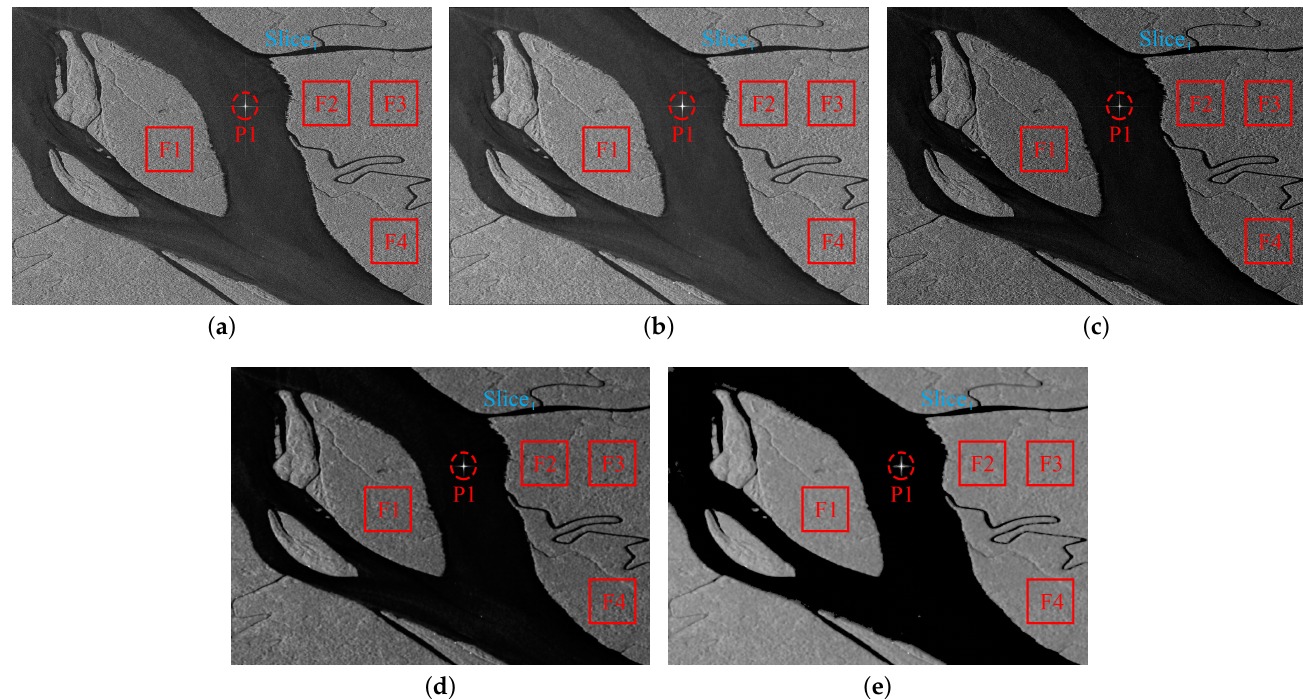
Figure 6. Experimental results for data 2 under full sampling condition. ( a ) Chirp scaling. ( b ) CSA + multilook processing using a 9 by 9 window. ( c ) L 1 regularization. ( d ) L 1 and TV regularization. ( e ) Nonconvex and TV regularization. The vertical direction of the image is the azimuth direction, and the horizontal direction is the range direction. SAR data 2 occupies 3115 (azimuth) × 4387 (range) sampling points, and the size of the corresponding scene is 19,228 m (azimuth) × 4935 m (range). All the images are plotted with the same color